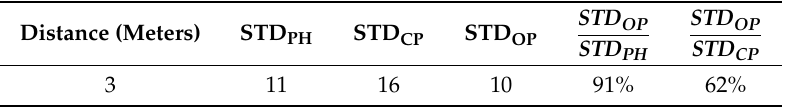
Table 5. Relation between errors of measurements by Photogrammetry, 3D Photomodeling and the estimated error of the operator (unit: